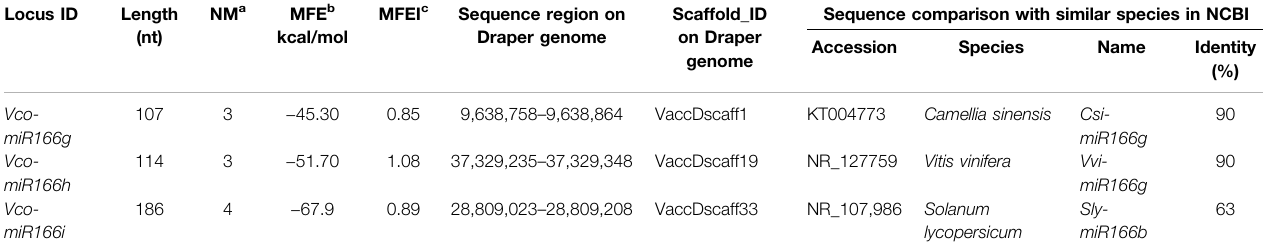
TABLE 1 | Characteristics of three newly identi fi ed miR166 precursors in highbush blueberry. Locus